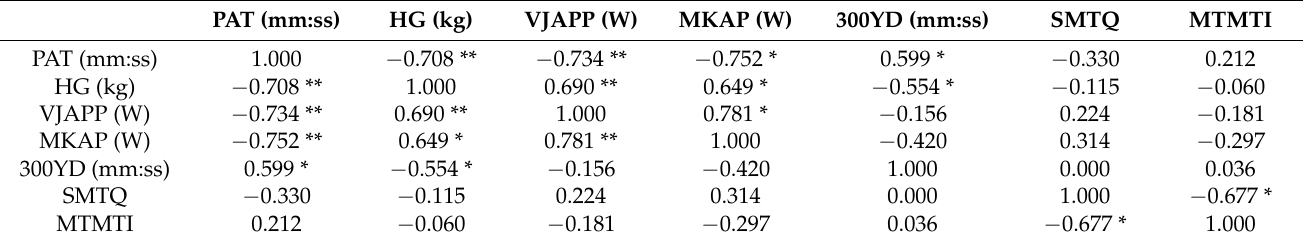
Table 4. Pearson’s correlations between PAT Scores, AF Parameters, and MT